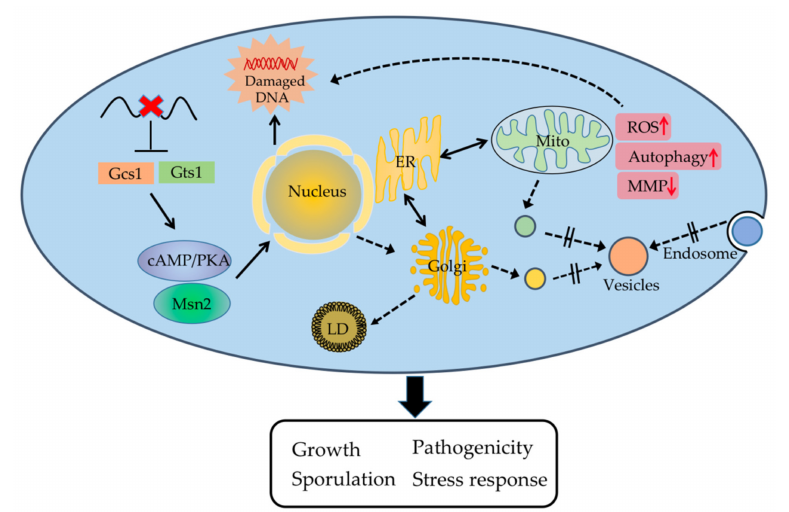
Figure 9. Schematic diagram of the regulation of AoGcs1 and AoGts1 in A . oligospora . In A. oligospora , AoGcs1 and AoGts1 are involved in intracellular signaling related to cAMP/PKA, which